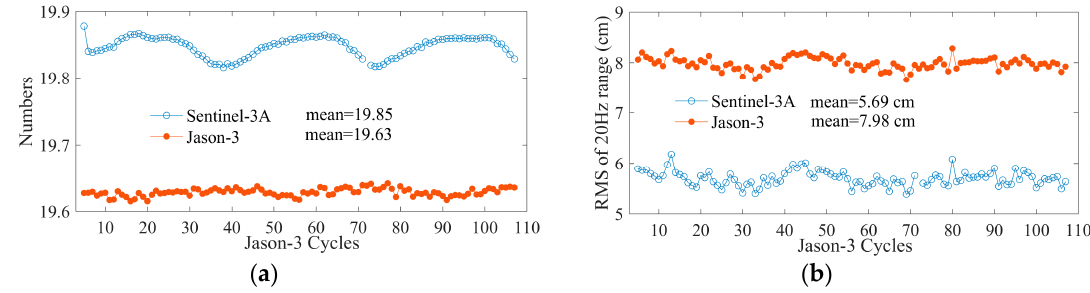
Figure 3. Cycle by cycle mean of ( a ) number and ( b ) RMS of 20 Hz range measurements according to Jason-3 repeat cycles.